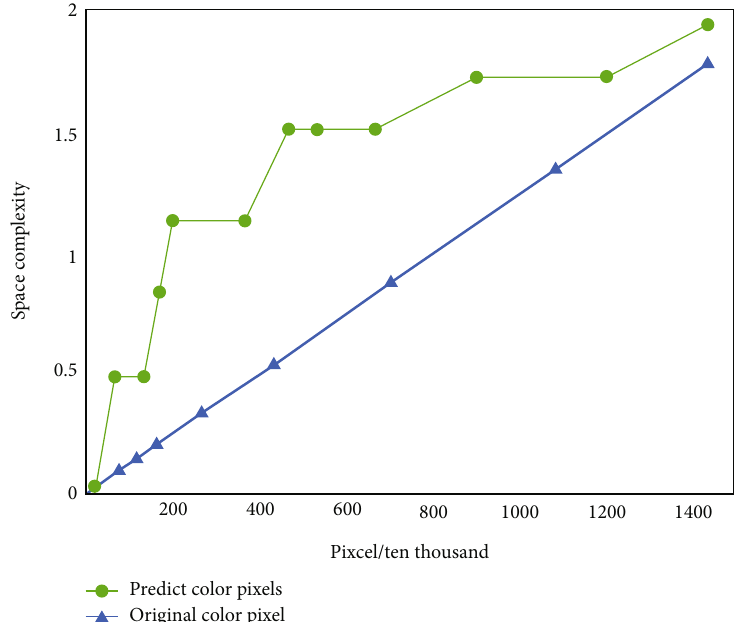
Figure 3: The spatial complexity of the original color matching pixels of ceramic materials and the pixels obtained after